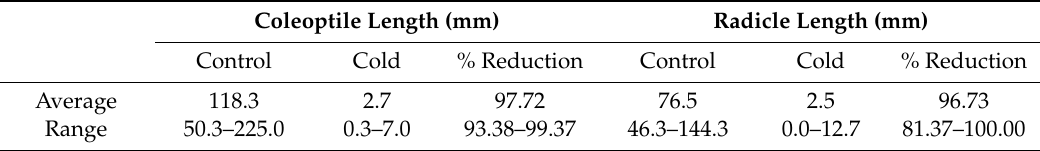
Figure 3. Top ten varieties that had the highest coleoptile length ( A ) and radicle length ( B ) under the cold condition. Means with same letters have no significant difference between varieties ( n = 4; p < 0.05). Values are mean ± SE ( n = 4). Table 3. Summary of coleoptile length and radicle length of rice varieties under the control (25 °C) and cold stress (13 °C) conditions.